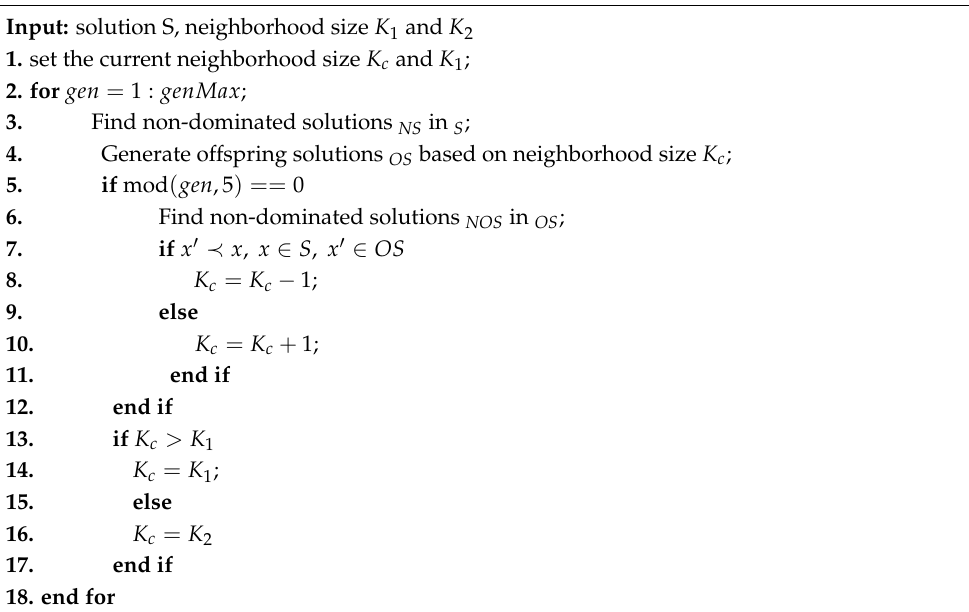
Algorithm 1: Framework of the K-nearest neighborhood